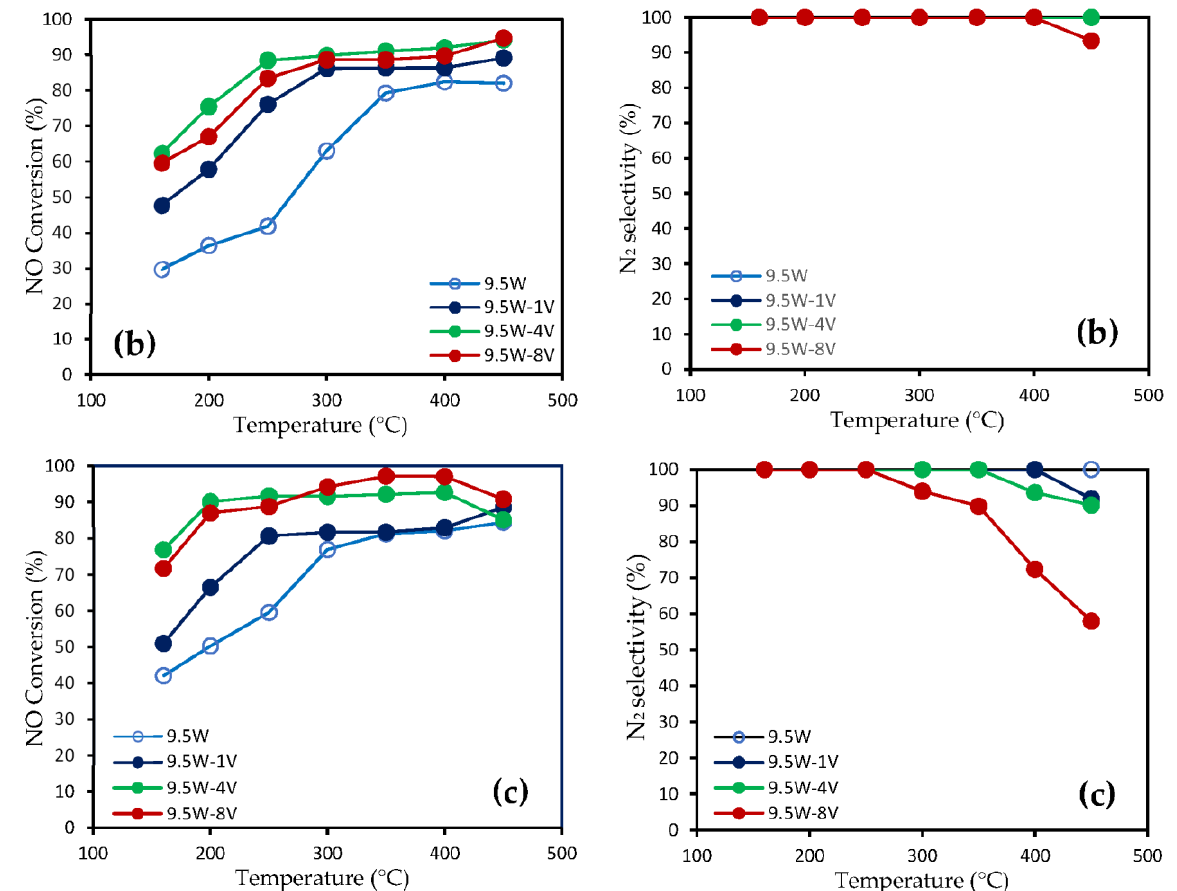
Figure 3. Conversion and N 2 selectivity profiles vs. temperature recorded on 9.5W- x V during ammonia SCR: ( a ) Dry ID 2 operating conditions on preheated freshly prepared samples; ( b ) Wet conditions ID 3; ( c ) Dry conditions ID 2 on samples exposed to wet conditions according to ID3. Gas hourly space velocity of 75,000 mL.h −1 .g −1 .